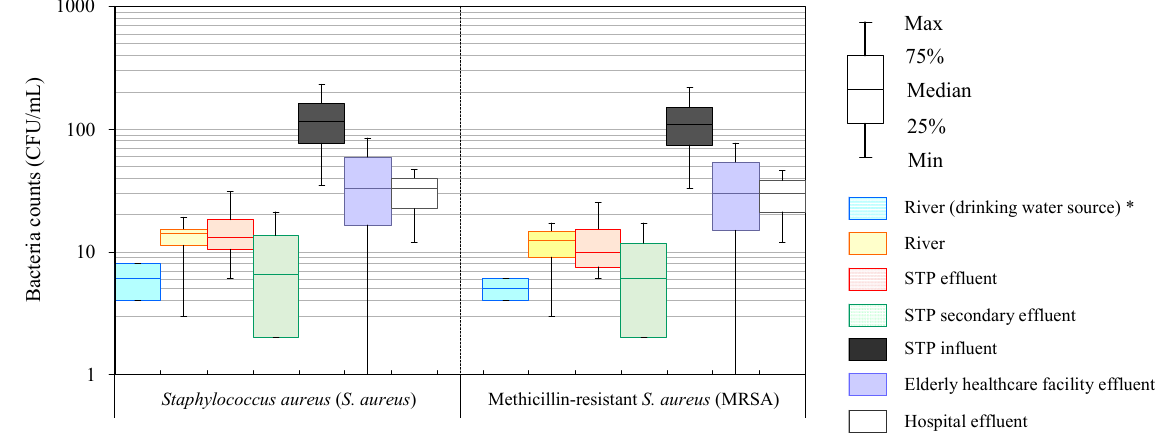
Figure 1. Distribution of Staphylococcus aureus ( S. aureus ) and methicillin-resistant Staphylococcus aureus (MRSA) in hospital effluent, elderly healthcare facility effluent, sewage treatment plant (STP) influent, STP effluent, and river water (*: The river water as a drinking water source was supplied to the study area and neighboring regions).